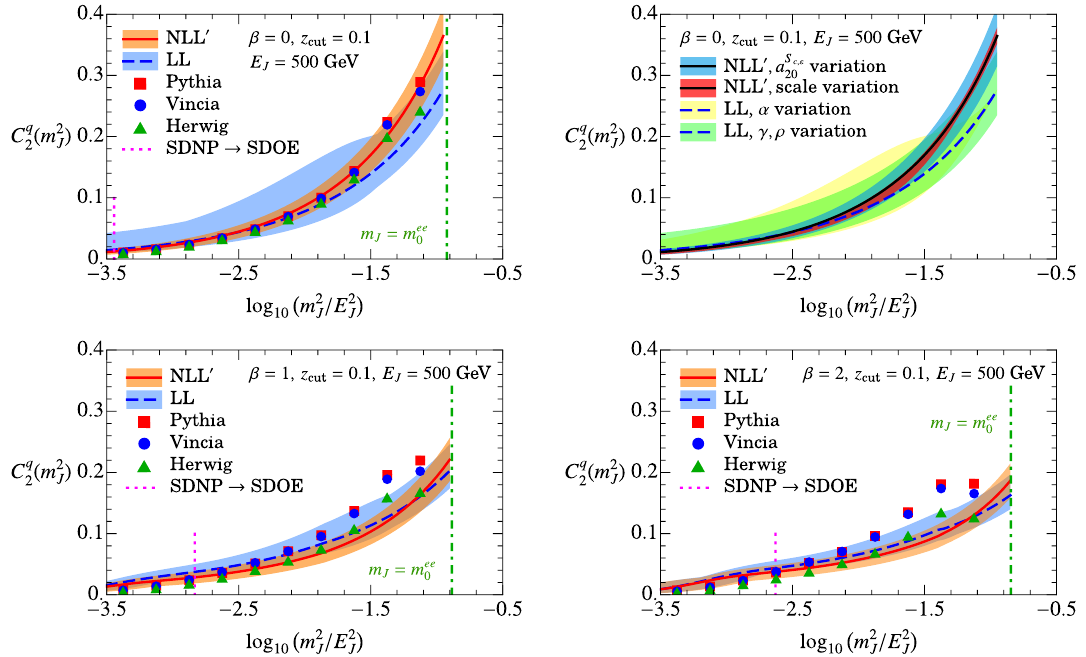
Figure 12 . Uncertainty estimate for the NLL 0 (orange band) and LL (blue band) effective theory predictions for the perturbative coefficient C q , at different values of β . The right top panel shows 2 the breakdown of the LL envelope into the various sources of variation, showing that the large uncertainty is induced by the trumpet variation (yellow) rather than by breaking the canonical re- lations (green). The same panel shows that at NLL 0 varying the two-loop constant (blue) dominates over the scale uncertainty